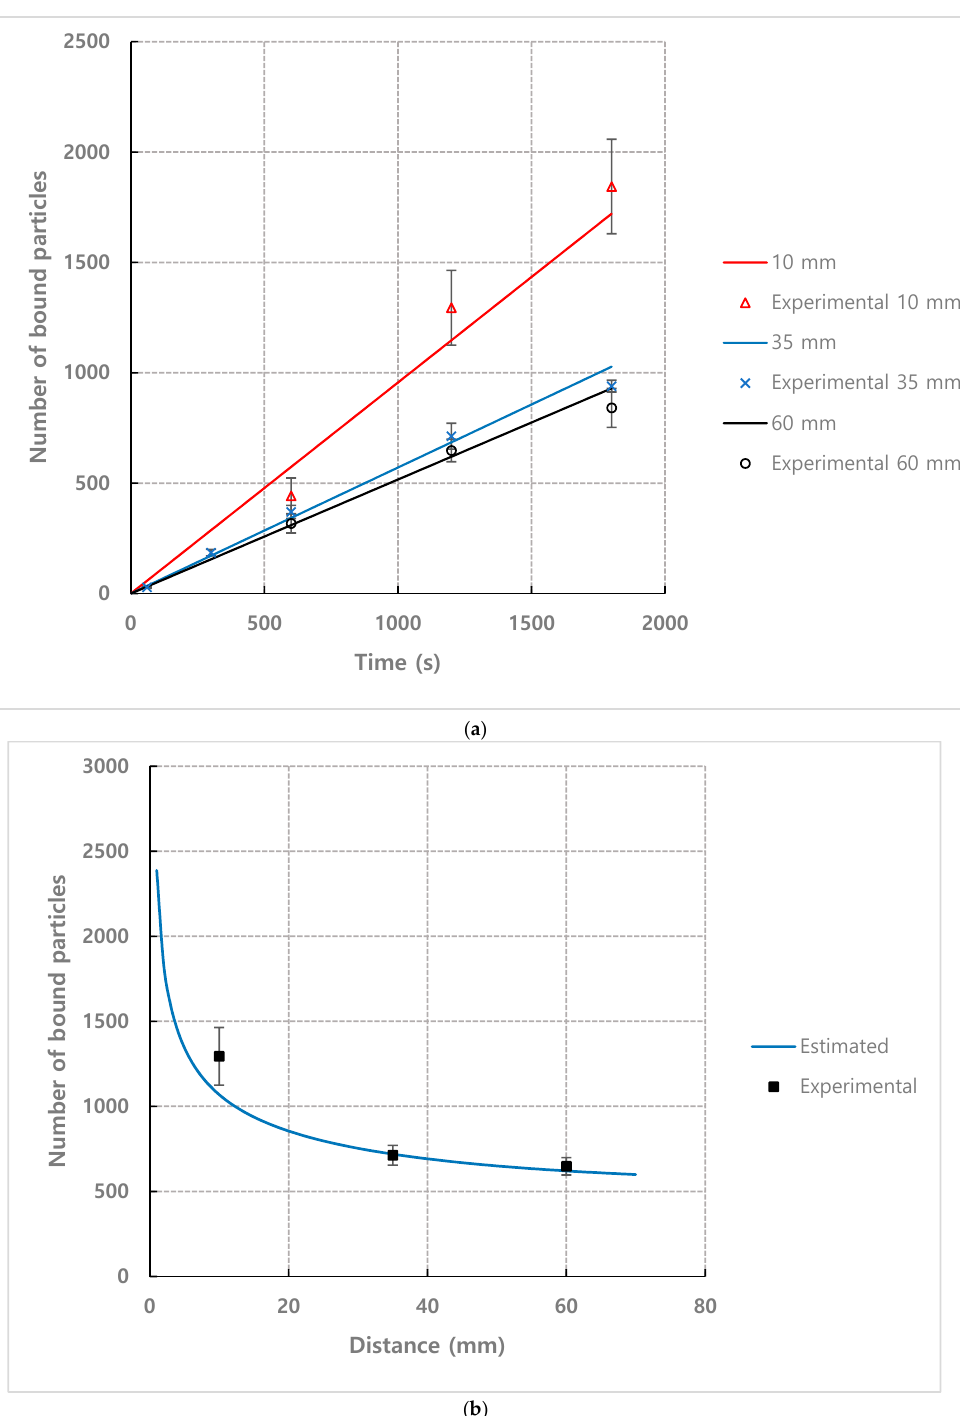
Figure 15. Comparison for number of bound particles from experiment and mathematical model (Equation (7)) for n = 1.93 × 10 14 m − 3 , flow rate = 1.2 mL · h − 1 . ( a ) depending on observation position (Coe ffi cients of determination are R 2 = 0.95 for 10 mm, R 2 = 0.98 for 35 mm and R 2 = 0.94 for 60 mm), ( b ) when detection time is set to 20 min. ( C = 0.0395, D = 2.4 × 10 − 12 m 2 · s − 1 , W 1 = 1362 µ m, W 2 = 1021 µ m are used for Equation